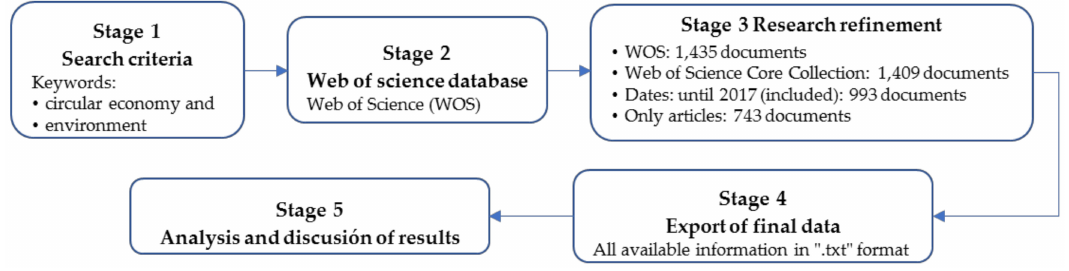
Figure 1. Five stages of bibliometric